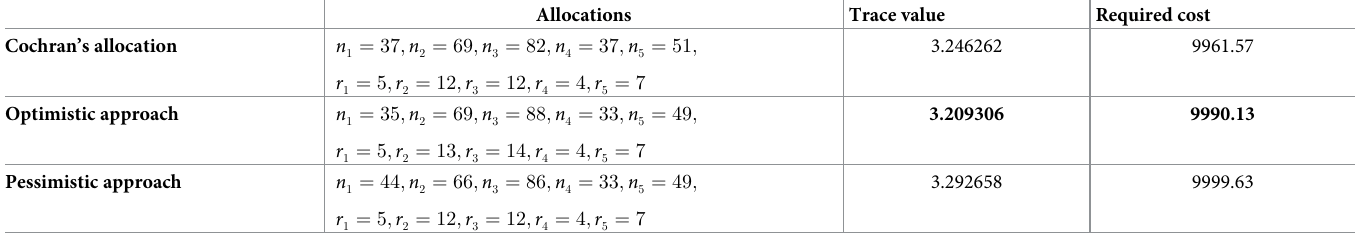
Table 5. Allocation of trace values with incurred survey cost for the nonresponse case. Allocations Trace value Required